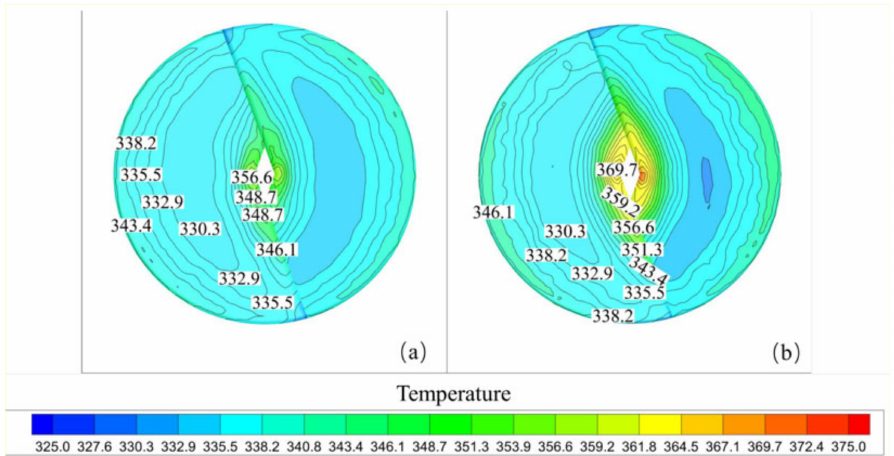
Figure 9. Temperature distribution on the metal plates of the susceptors at different angles: ( a ) 10 ◦ cross angle susceptor; ( b ) 15 ◦ cross angle